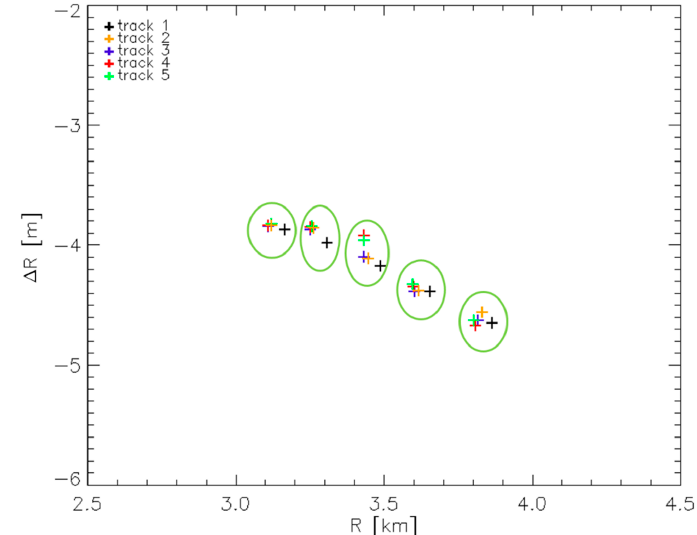
Figure 8. Relevant to Equation (3), to the 5 CRs and the 5 acquisitions considered in the Experiment 5: difference Δ R as a function of the CRs-to-radar distances R. Each color indicates a different radar acquisition. Each green circle groups the same CR in the five different acquisitions.